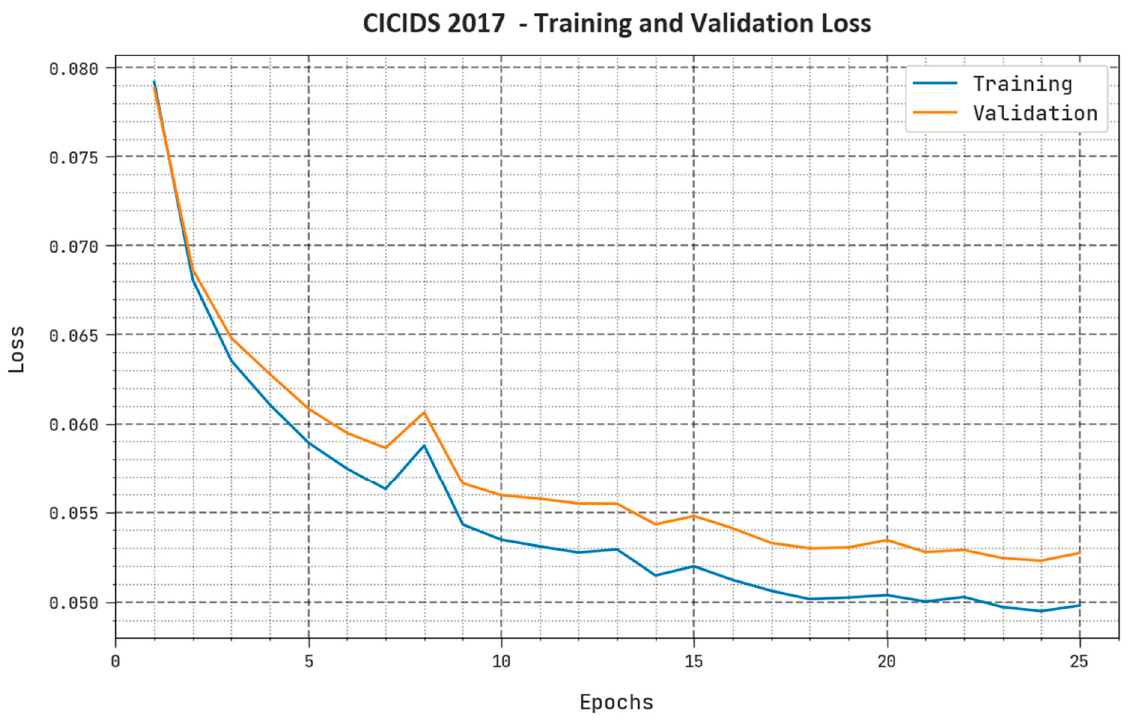
Figure 8. TLOS and VLOS outcome of XAIID-SCPS system on CICIDS 2017 dataset.